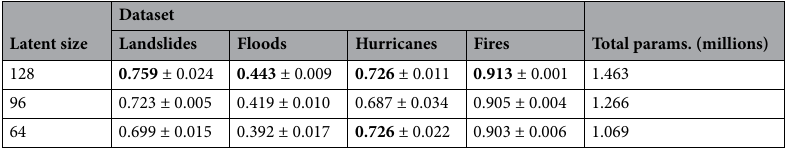
Table 6. AUPRC and for models with different latent sizes (averaged over 5 runs). The AUPRC results are for the cosine similarity of the embedding with a history of 3 frames. Models use parameters for the default large model, but use variable latent sizes. We also show the total number of parameters of each model.